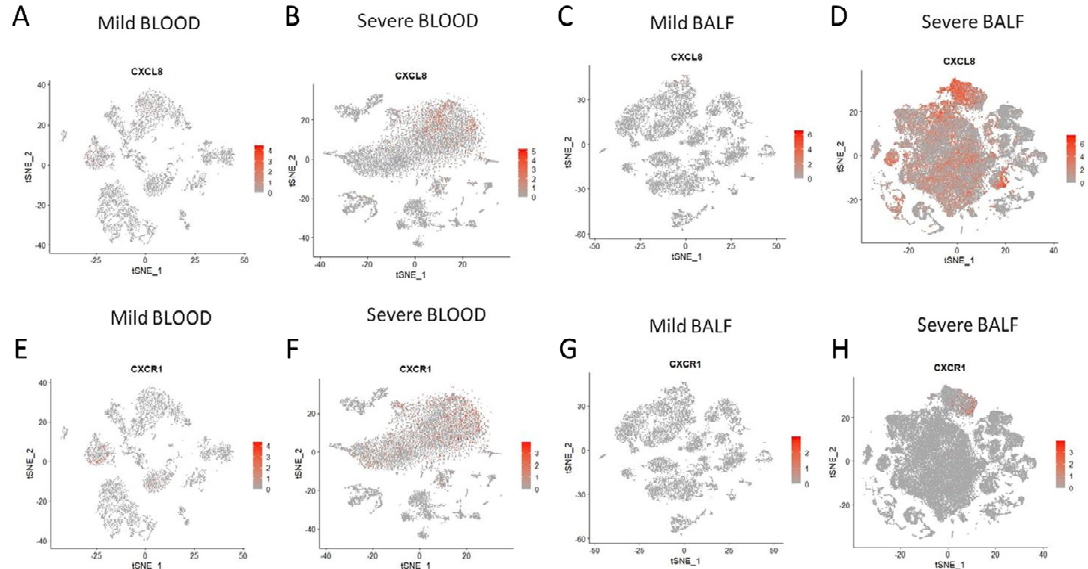
Figure 4. Re-analyses of single-cell RNA sequencing data to show expression of IL-8 and its receptor among all cells. ( A – D ) Abundance of IL-8 transcript (CXCL8) among different subsets of cells isolated from peripheral blood ( A , B ) and bronchoalveolar lavage fluid ( C , D ), compared between mild ( A , C ) and severe ( B , D ) COVID-19 patients. ( E – H ) Abundance of transcript for IL-8 receptor (CXCR1) among different subsets of cells isolated from peripheral blood ( E , F ) and bronchoalveolar lavage fluid ( G , H ), compared between mild ( E , G ) and severe ( F , H ) COVID-19 patients. Data analyzed from public datasets GSE163668 (blood cells) and GSE145926 (cells from bronchoalveolar